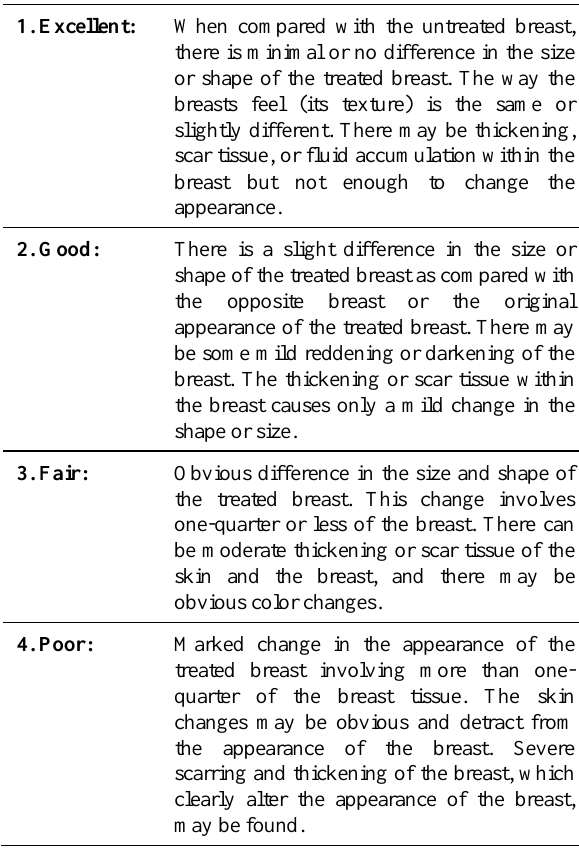
Table 1: Harvard / National Surgical Breast and Bowel Project